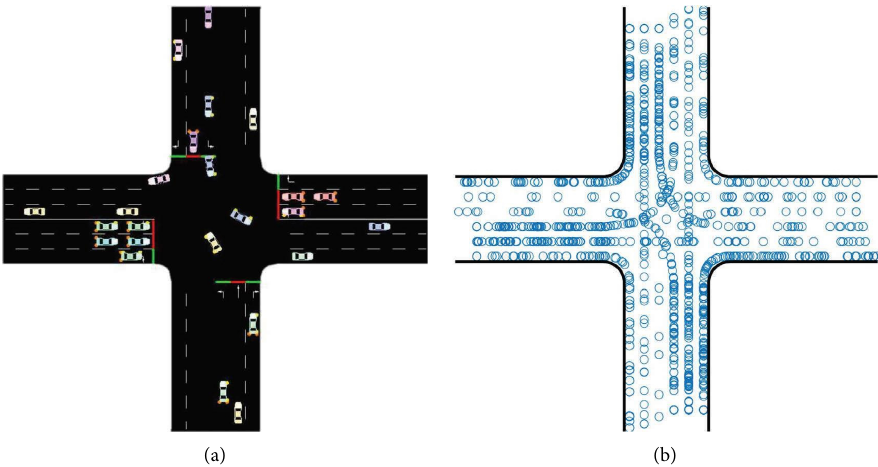
Figure 5: SUMO trafc generation: (a) mobile user distribution snap-shot and (b) user locations for the PMI and CQI feedback over one iteration period.